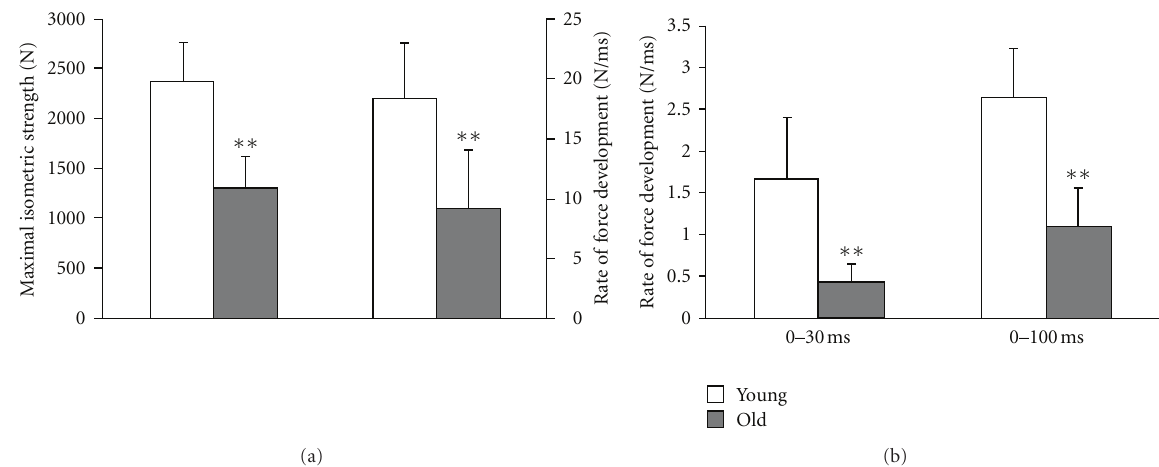
Figure 1: Age-related di ff erences in strength. (a) Maximal isometric strength and rate of force development. (b) Rate of force development over time intervals of 0–30 ms and 0–100 ms. Young di ff erent from old: ∗∗ P < 0 . 01. Adapted from Granacher et al. [15].